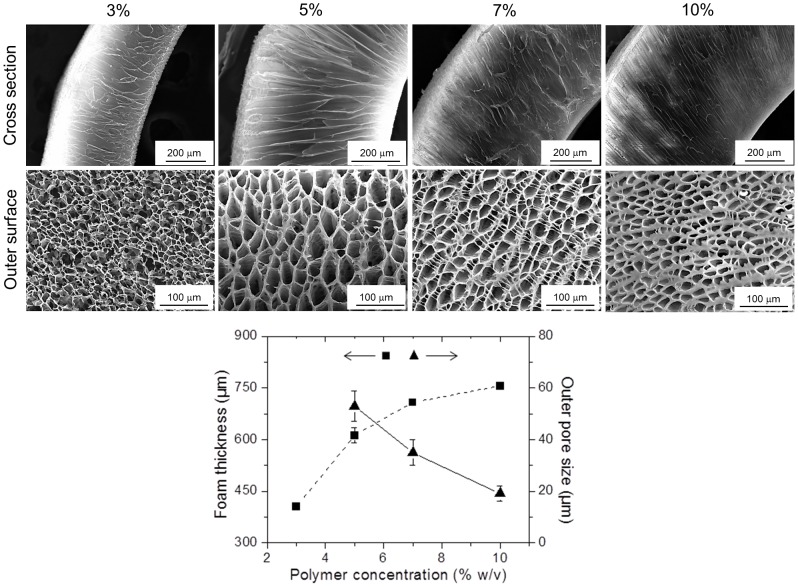
Influence of the polymer concentration.SEM images of the cross section and the outer surface of the PLCL300 scaffolds prepared from variable concentration (3, 5, 7 and 10% w/v, quenched at −80°C for 30 s) demonstrated that the pore size was inversely proportional, and the pore wall thickness and the overall foam thickness was directly proportional to increase in the polymer concentration. Measurements were performed by Image J (n = 25). The differences in the foam thickness or the pore size between any two groups were found to be statistically significant. The correlation coefficients between the polymer concentration and the outer pore size and the foam thickness were calculated to be −0.99 and +0.92, respectively.